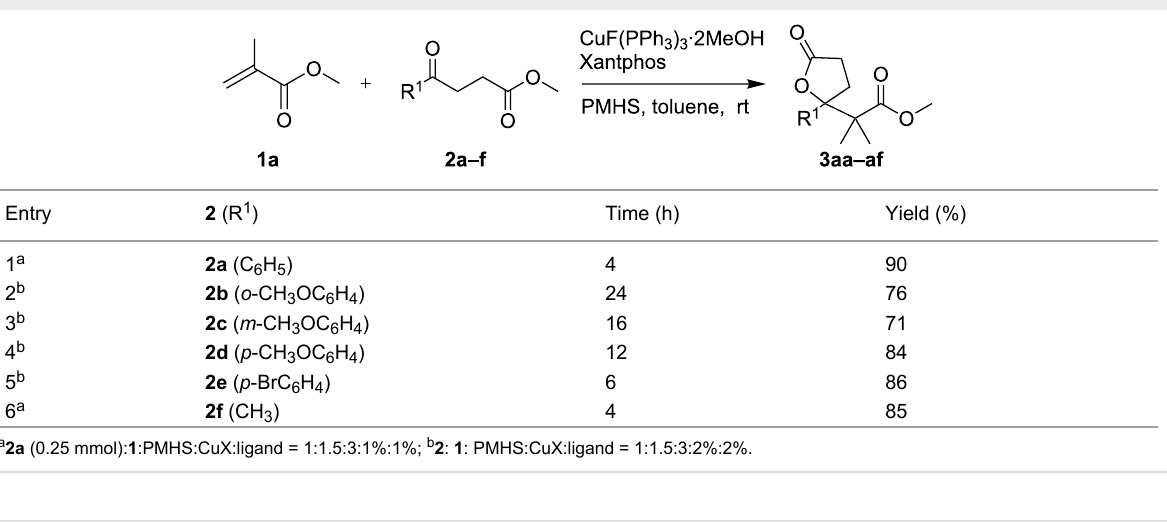
Table 1: Reactions of methyl 4-oxocarboxylates with methyl methacrylate.